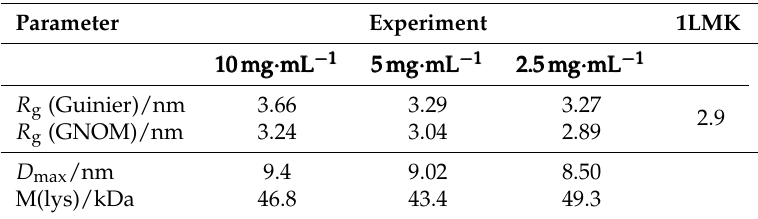
Table 1. Structural parameters derived from experimental SAXS data. Here, R g indicates the radii of gyration as computed by a Guinier and GNOM analysis, respectively. D max is the maximum dimension of the 3H3 diabody is obtained from the p ( r ) functions. M ( lys ) is the molecular mass as obtained from the SAXS data using lysozyme as a standard.